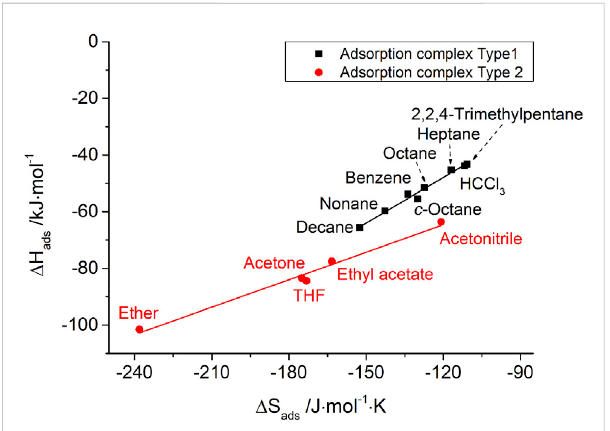
FIGURE 8 Enthalpy – entropy compensation for probe molecules with two types of adsorption complexes on MPTMS-modi fi ed porous silica.